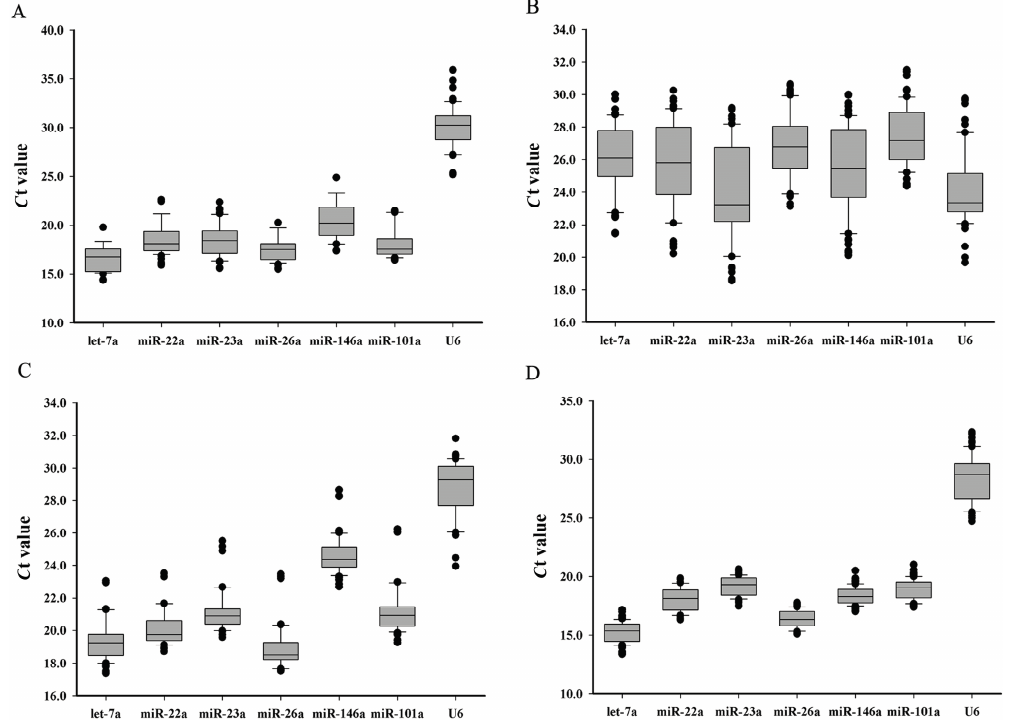
Figure 1. Threshold cycles ( C t ) comparison of six reference miRNAs and U6. ( A ) In different adult tissues; ( B ) In different embryonic developmental stages; ( C ) In different post-embryonic developmental stages; and ( D ) In fasting-refeeding treated liver